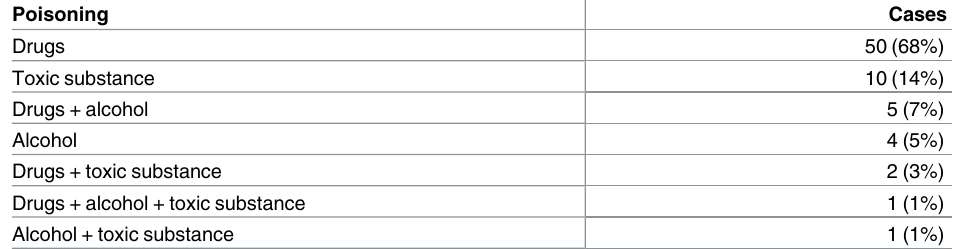
Table 4. Poisoning among SITBs casesvisited in the EDs: frequency and percentage (%) of cases for each substance used (n = 73).